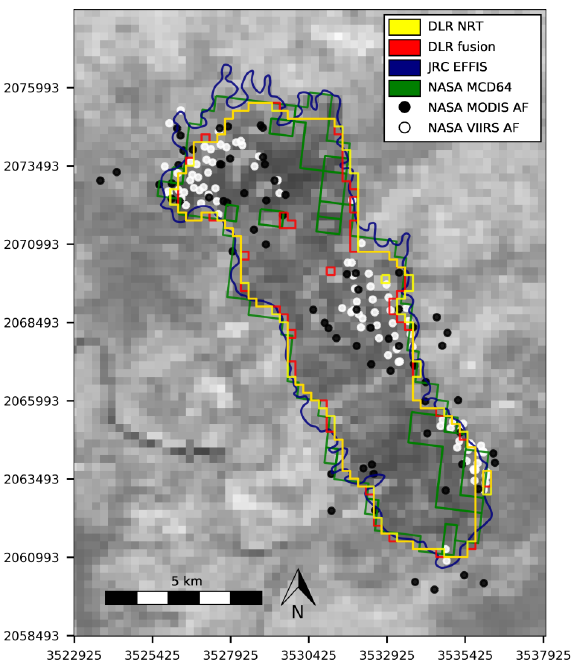
Figure 6. Combined visualization of final results and reference datasets. Active fire (AF) locations from MODIS and VIIRS (black and white dots, respectively) are additionally